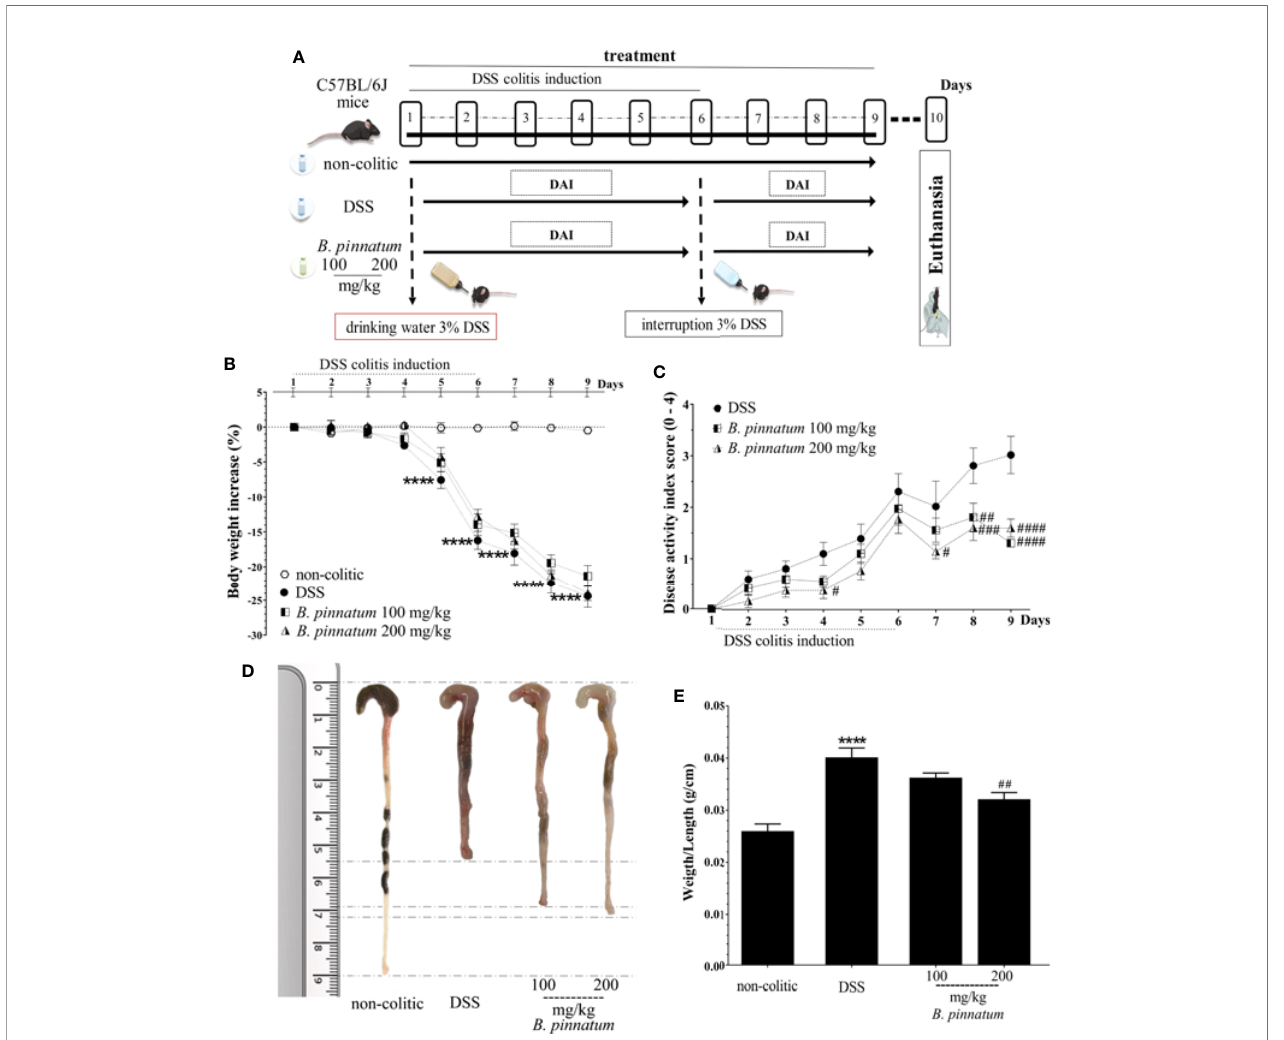
FIGURE 6 | Dextran sulfate sodium (DSS) – induced colitis experimental design (A) and effects of treatments with hydroethanolic extract from B. pinnatum leaf (HEBP) on weight loss (B) , disease activity index (DAI) (C) , damage (D), and weight/length ratio (E) of the colon. Data (n = 8) are presented as mean ± standard error from the mean. **** p < 0.0001 compared with non-colitic group; # p < 0.05, ## p < 0.01, ### p < 0.001, #### p < 0.0001 compared with DSS